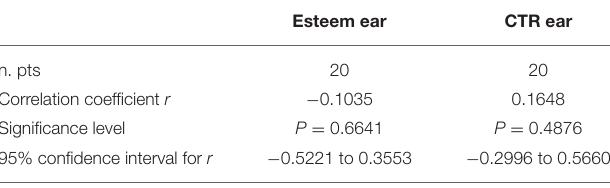
TABLE 2 | Correlation between timing of the follow-up and hearing loss severity.